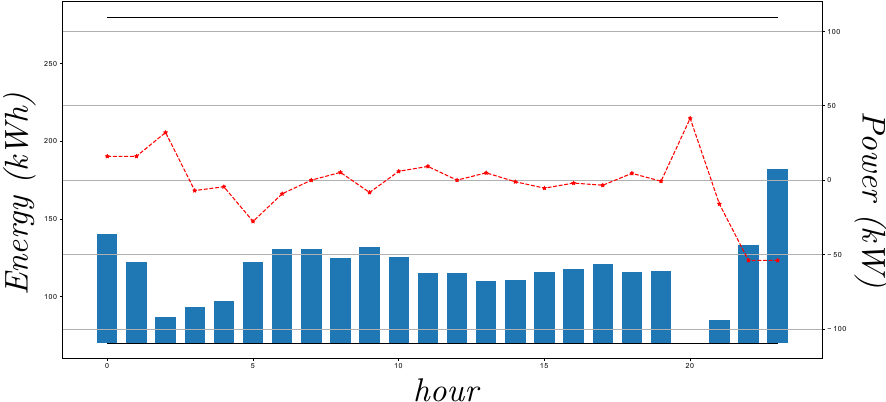
Figure 9. Battery management for Case Study 1 where the bars are the SOC at every time instant and the red dashed line is the power given or required by the